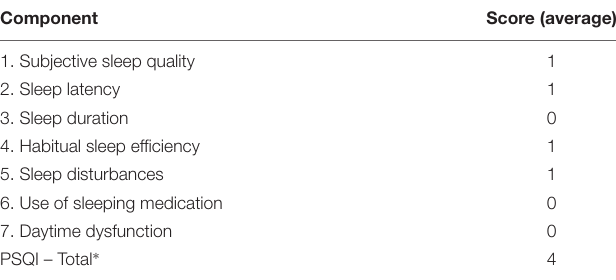
TABLE 2 | Average scores in the seven components of the PSQI.